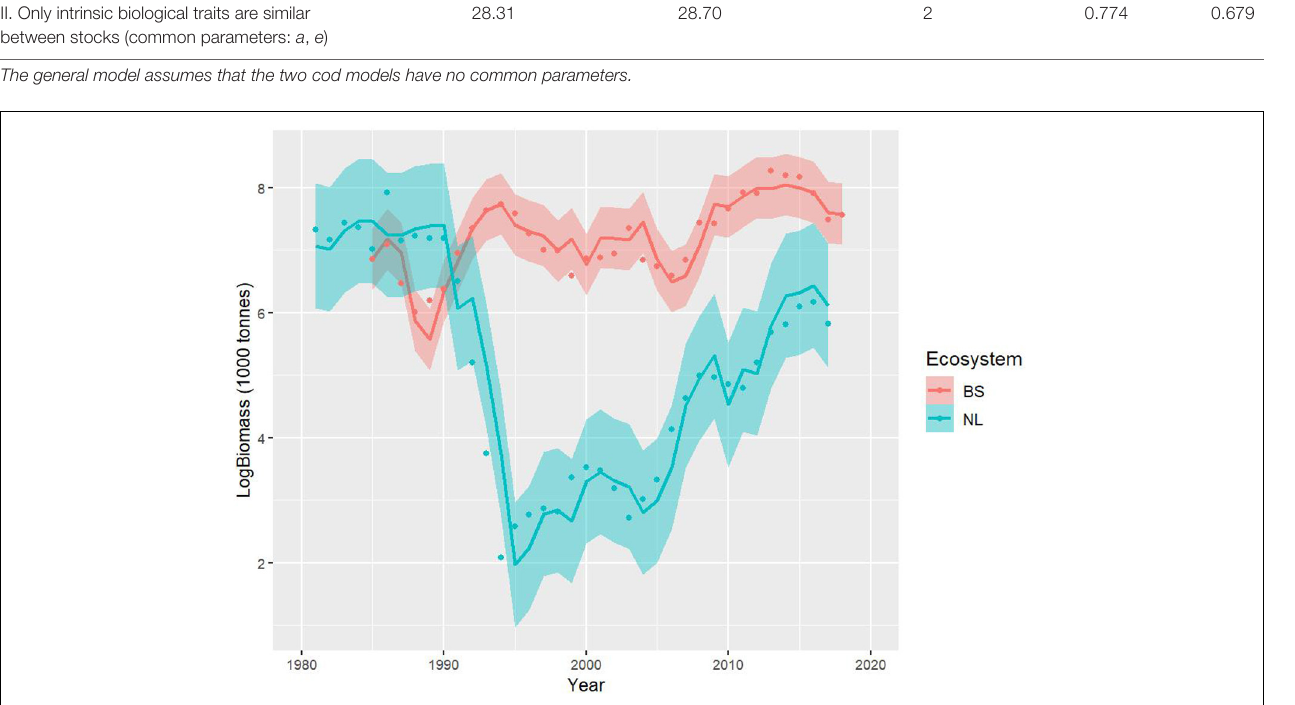
FIGURE 6 | Model fits (log scale) for the Newfoundland-Labrador shelves (NL) (blue line) and Barents Sea (BS) (red line) cod stocks and 95% confidence intervals (shaded areas). These fits correspond to the model assuming a and e as common parameters to both